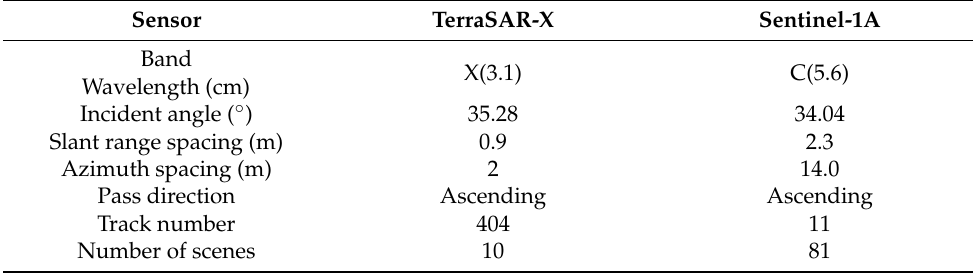
Table 1. Basic parameters of the used SAR satellite systems.